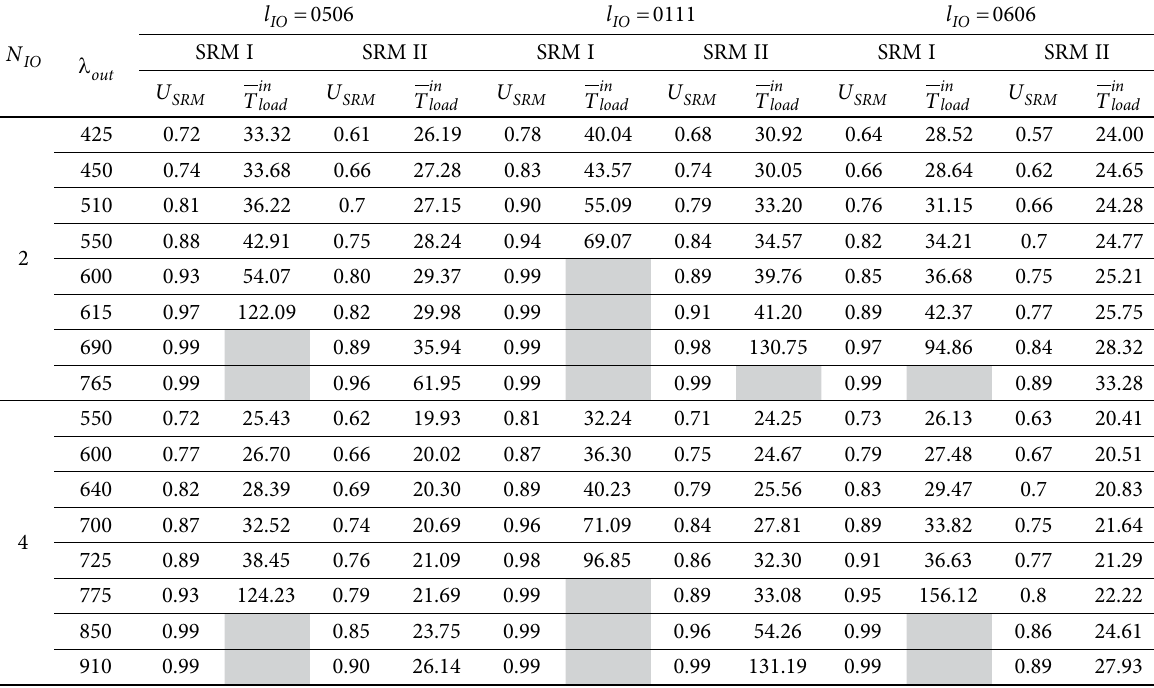
Table. SRM utilization SRM U and average load input to the system time of parameters IO l , IO N and l